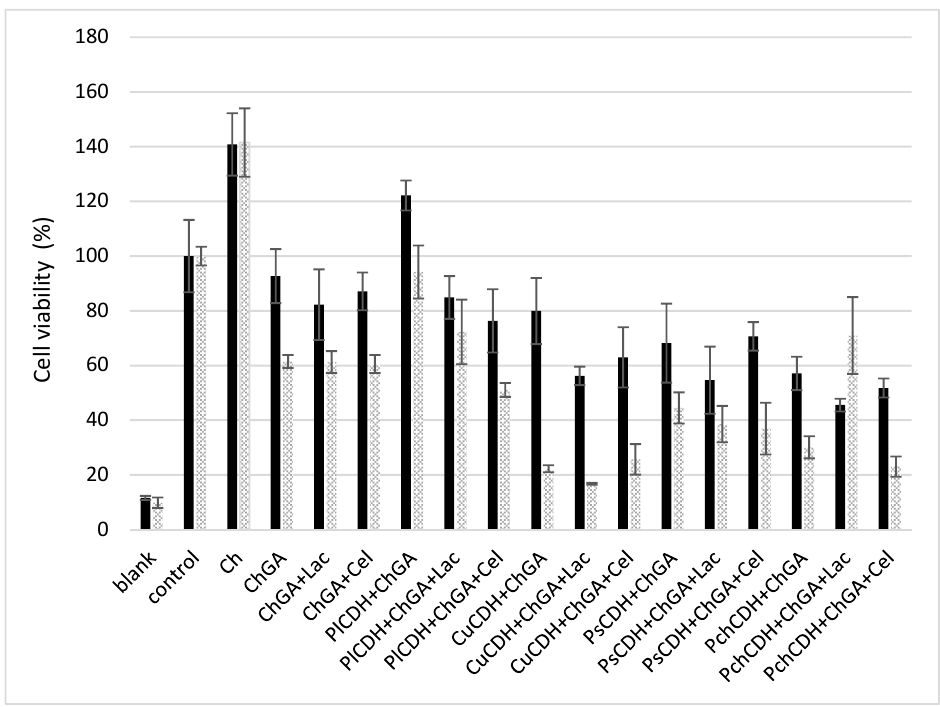
Figure 6. MTT cell viability assay of Vero cells incubated for 24 and 48 h with different chitosan beads: without glutaraldehyde (Ch), with glutaraldehyde (ChGA), with lactose (ChGA + Lac), or cellobiose (ChGA + Cel), containing CDHs isolated from Phlebia lindtneri ( Pl CDH), Cerrena unicolor ( Cu CDH), Pycnoporus sanguineus ( Ps CDH), and Phanerochaete chrysosporium ( Pch CDH) . Data are mean ± SD for three measurements (n = 3).